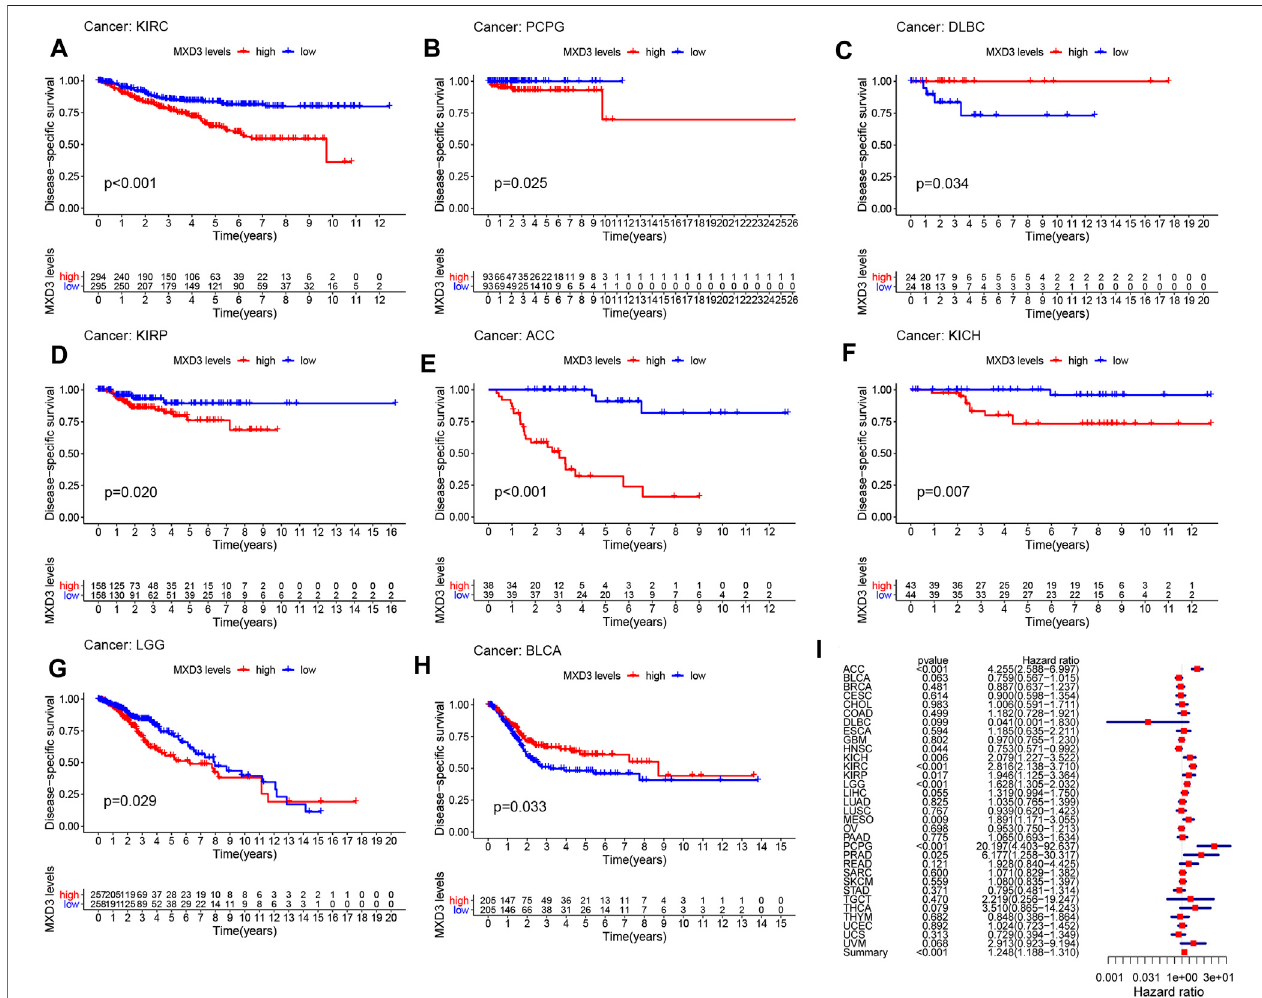
FIGURE3| DSSwithdifferentMXD3expressioninKIRC (A) ,PCPG (B) ,DLBC (C) ,KIRP (D) ,ACC (E) ,KICH (F) ,LGG (G) ,andBLCA (H) .CoxregressionofMXD3 and DSS (I) in cancer